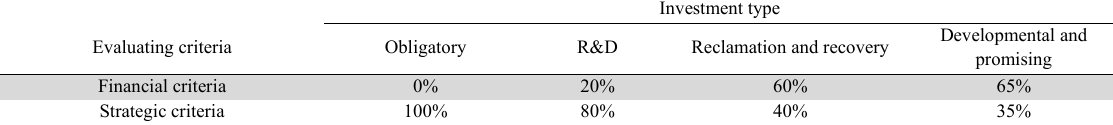
The degree of importance of financial and strategic criteria in different investment groups in agri- culture sector